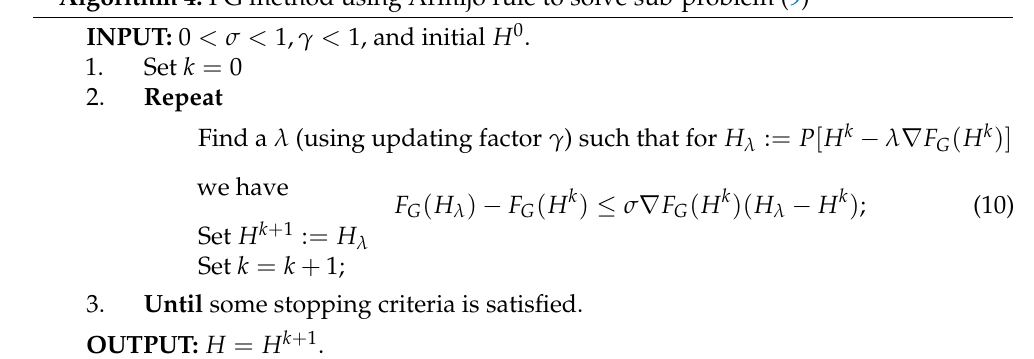
Algorithm 4: PG method using Armijo rule to solve sub-problem